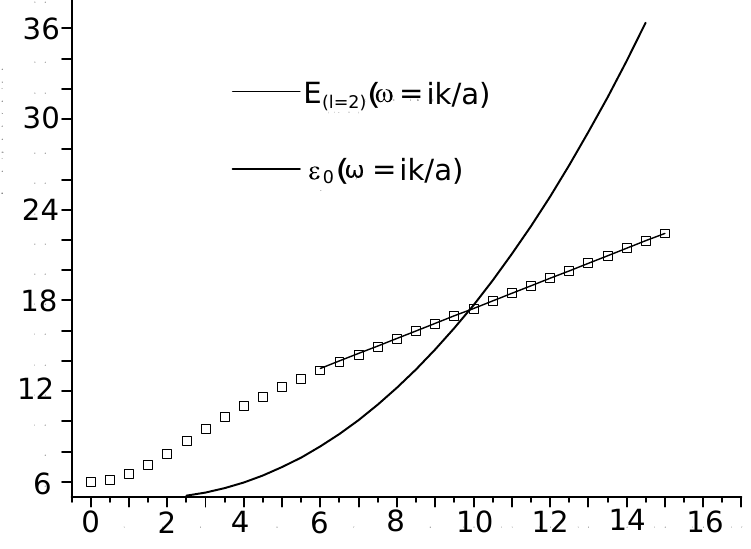
Figure 1. Intersection of the numerically generated curves E ( (cid:96) = 2 ) ( ω = ik / a ) and (cid:101) o ( ω = ik / a ) for a / M = 1.4. Note the agreement with the results in [19], according to which for a = 1.4 the intersection occurs at k (cid:39) 7.07 × 1.4 =